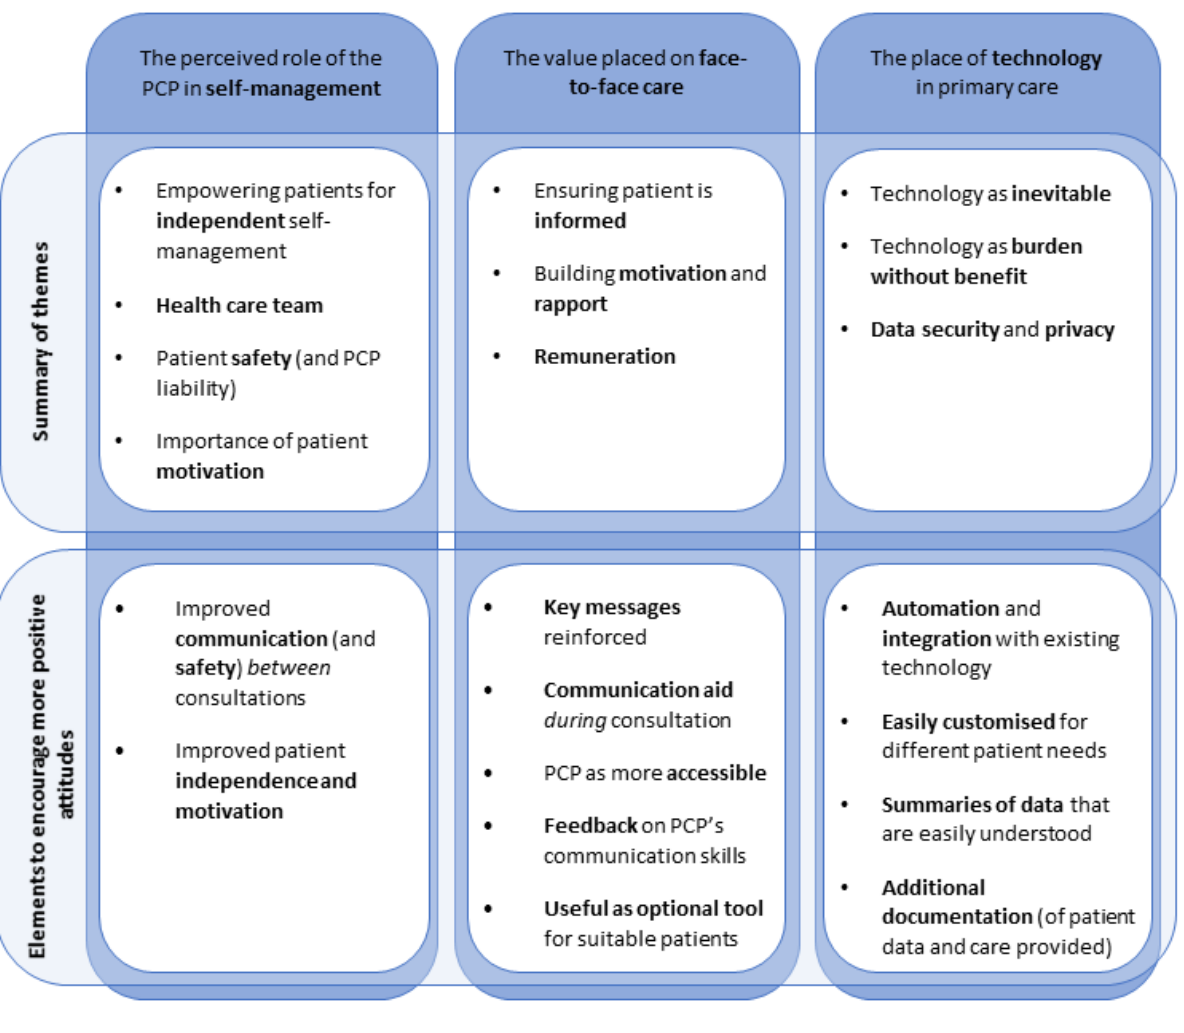
Figure 1. Mind map of themes. PCP: primary care